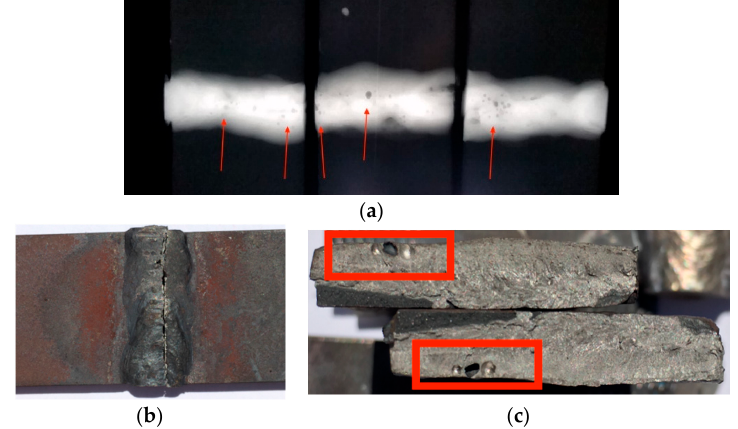
Figure 7. View of several rejected samples: ( a ) X-ray example of rejected samples due to the presence of defects in the weld bead (filler metal); ( b ) rejected sample which ruptured through filler metal due to the presence of pores; and ( c ) view of pores in the filler metal.